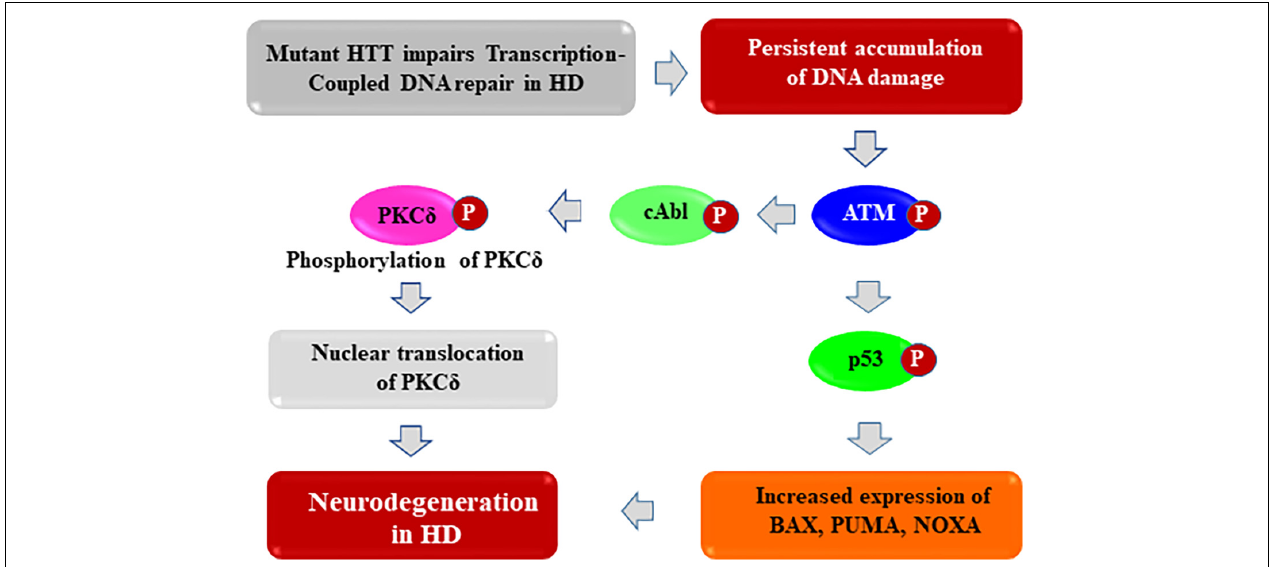
FIGURE 4 | Proposed mechanism by which mHTT activates pro-apoptotic signaling to trigger neurotoxicity in HD. The huntingtin (HTT) protein probably acts as a structural scaffold to assemble a novel macromolecular transcription-coupled DNA repair (TCR) complex with RNA polymerase large subunit, various transcription factors and cofactors, and DNA repair enzymes including DNA ligase 3 (LIG 3) and DNA strand break repair enzyme PNKP (polynucleotide kinase 3 (cid:48) -phosphatase). This novel multi-protein complex senses the DNA strand breaks/lesions during transcription elongation and orchestrates their faithful repair to strictly maintain genome integrity. By contrast, the presence of mHTT in the TCR complex impairs its activity resulting damage accumulation in neuronal genome. This results in enhanced phosphorylation of DNA damage-response serine-threonine kinase ATM, and DNA-dependent protein kinase (DNA-PK), leading to chronic activation of ATM and/or DNA-PK-dependent p53 and c-Abl kinase signaling cascade in HD. This trigger pro-apoptotic signaling pathways by enhancing expression of various p53 target genes such as BAX, PUMA, and NOXA in HD. In parallel, activated ATM/DNA-PK can also phosphorylate the c-Abl kinase, which in turn phosphorylate PKC δ , facilitating nuclear translocation of PKC δ . Nuclear translocation of PKC δ may further amplify the pro-apoptotic signal in HD, ultimately leading to neuronal degeneration and development of complex neurological phenotypes in